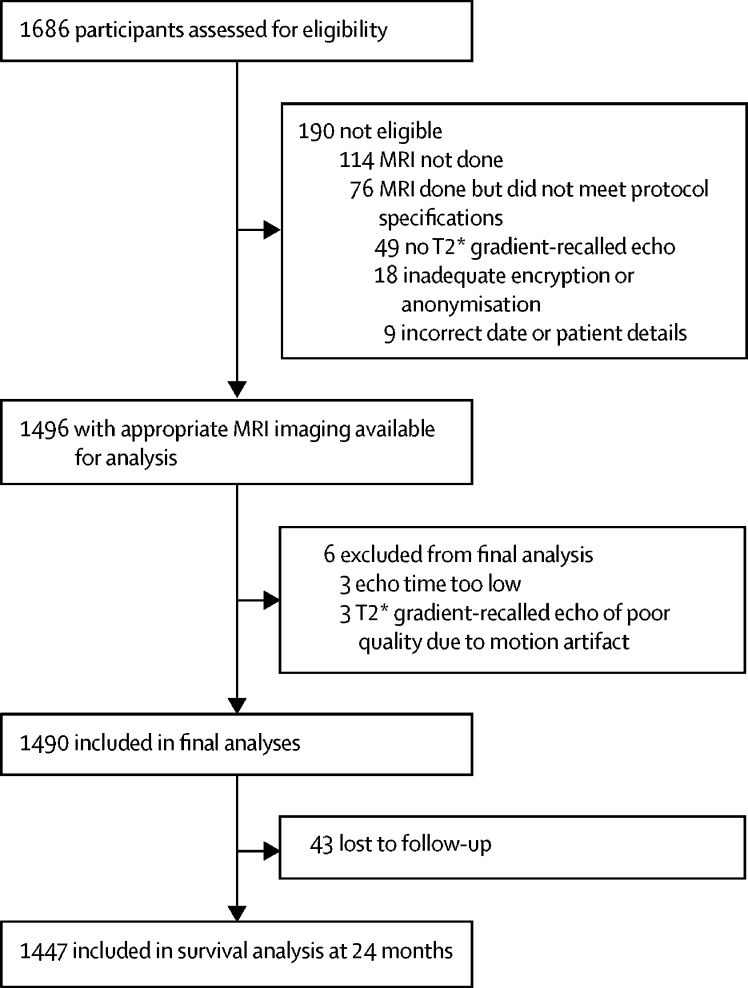
Participant flow